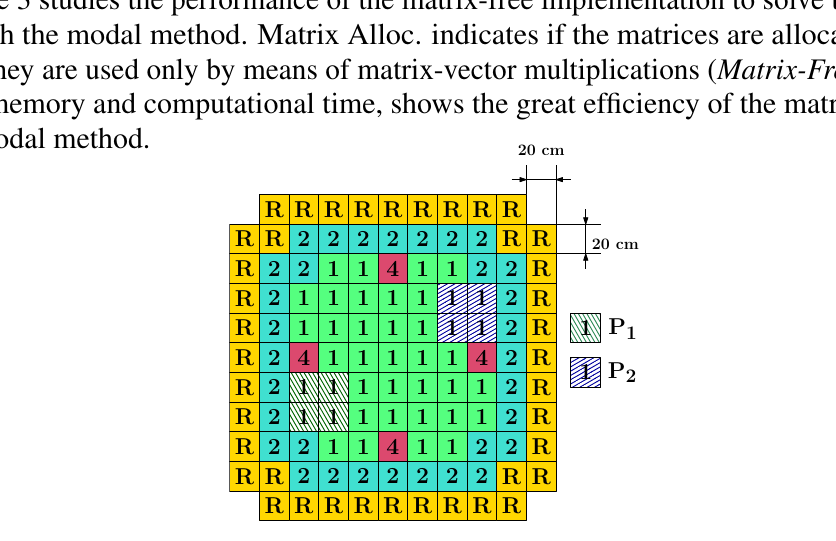
Figure 1: Geometry of the Langenbuch transient.